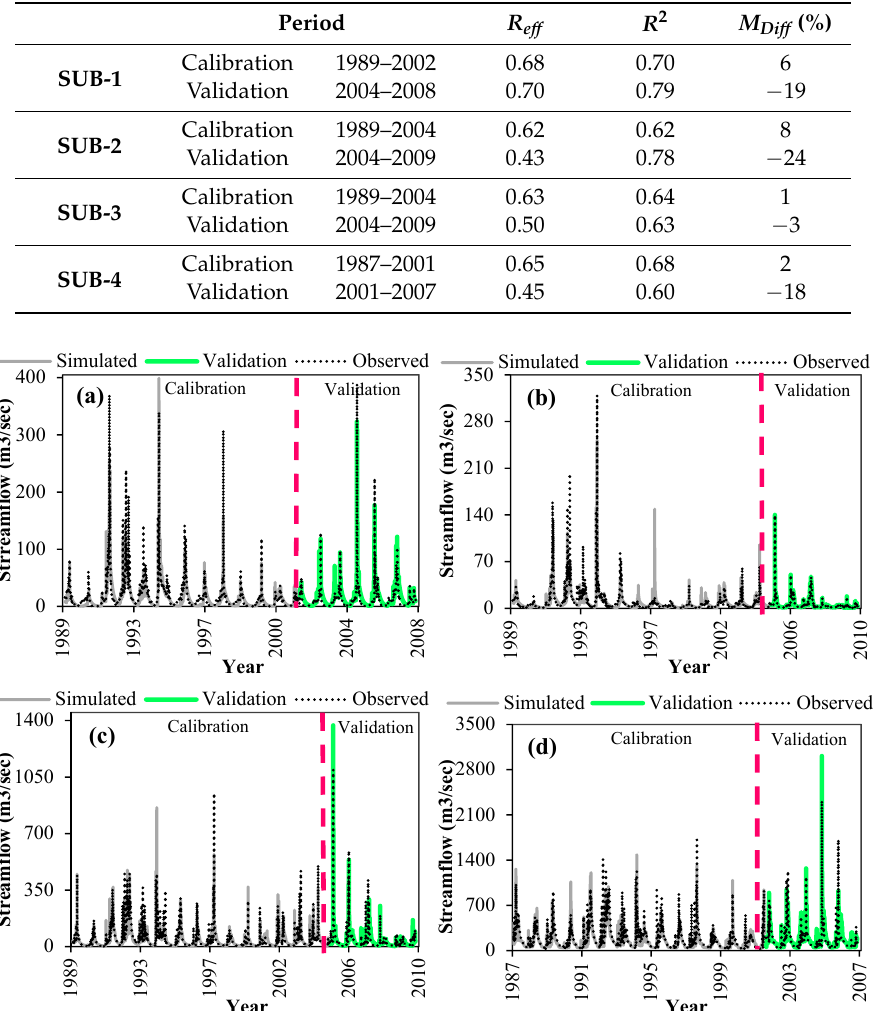
Table 3. The model performance statistics for the calibration and validation periods.